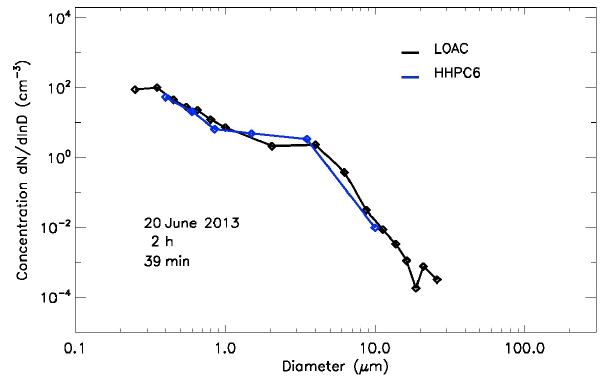
Figure 12. Example of size distribution for LOAC and HHPC-6 during an event of solid particles during the ChArMEx campaign at Minorca on 20 June 2013. The LOAC uncertainties are ± 20% for the higher concentrations and ± 60% for the lower